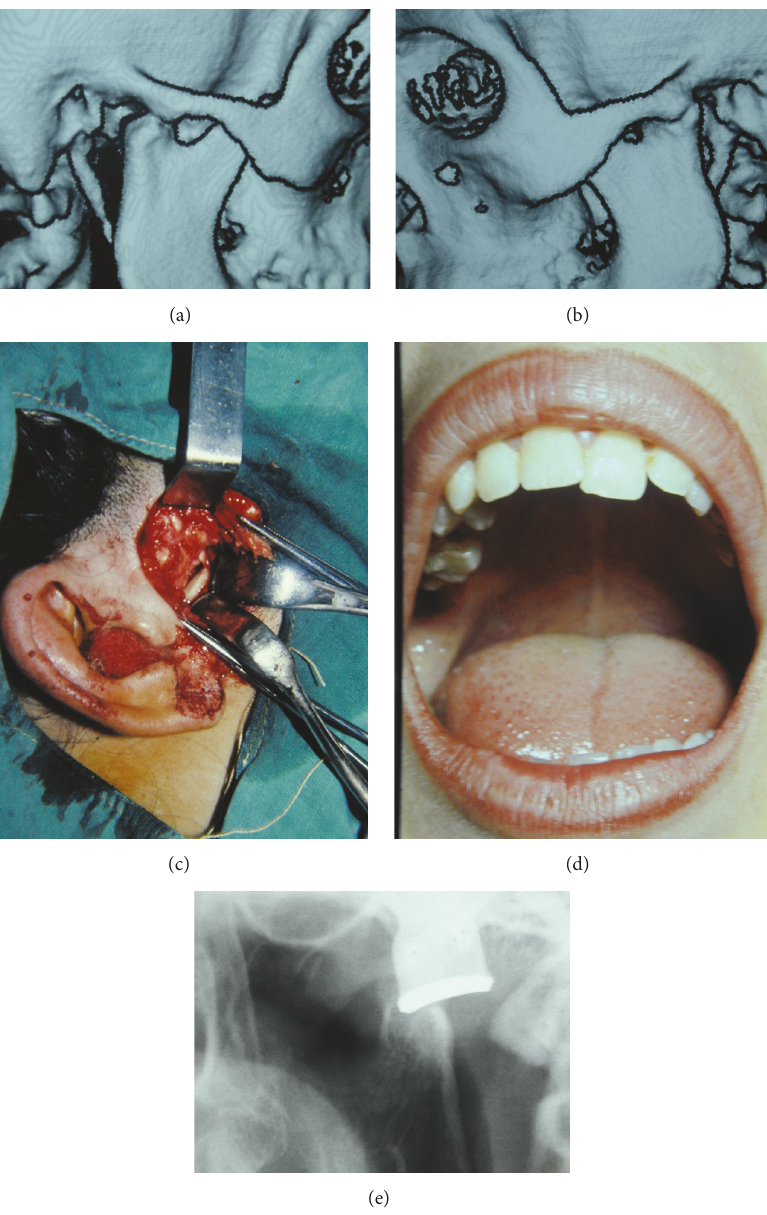
Figure 3: (a) During the examination of the patient (Case 2), CT revealed a spontaneously healed condyle after having a fracture at the right side. (b) Ankylosis at the left side (Case 2). (c) Horizontal resection of the ramus (Case 2). (d) Mouth opening provided by surgical treatment (Case 2). (e) Panorex shows a spontaneously healed condylar fracture at the right side and new condyle formation after surgical treatment of ankylosis at the left side (Case